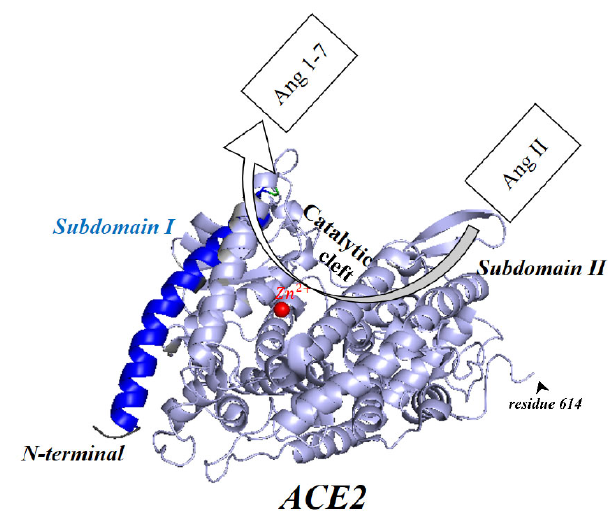
Figure 4. Three dimensional structure of the protease domain of ACE2 (PDB ID: 6M0J [24], PyMol molecular graphics system). The catalytic cleft, between subdomains I and II, involved in converting Ang II to angiotensin (1–7), is noticeable. The N-terminal helix in blue is the territory of binding of ACE2 with S protein. Residue 614 is the point of attachment of the catalytic domain on the way to C ‐ terminal with other domains of ACE2; the neck domain, the transmembrane domain and the cytoplasmic tail.